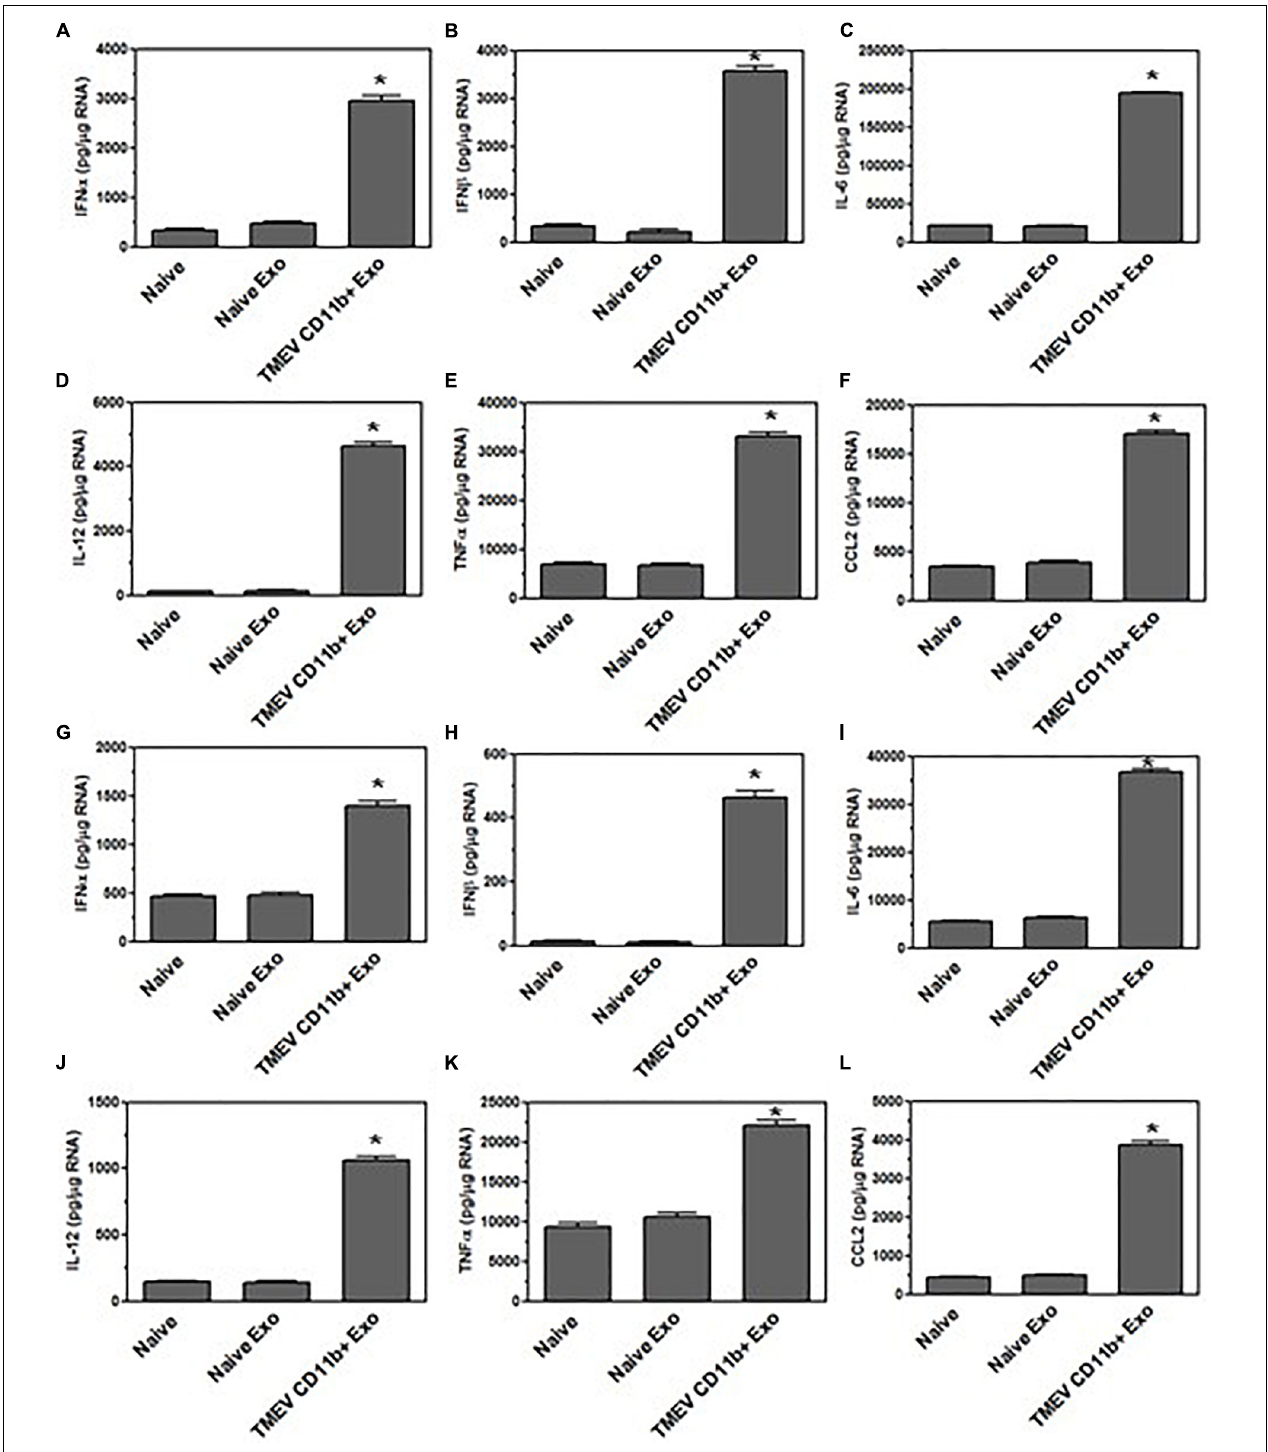
FIGURE 9 | Exosomes secreted by microglia during TMEV infection in mice activate bystander CNS cells. Exosomes were isolated from the brains of TMEV-infected mice at 2 days post-infection or from naïve mice (three mice per group). The exosomes were sorted for CD11b + exosomes which were placed on unstimulated astrocytes and neurons. After 24 h, the astrocytes (A–F) and neurons (G–L) were lysed, RNA isolated, converted to cDNA, and used in real time PCR with primers for IFN α (A,G) , IFN β (B,H) , IL-6 (C,I) , IL-12 (D,J) , TNF α (E,K) , and CCL2 (F,L) . Significant difference was determined by the one way ANOVA and Bonferroni’s multiple comparison test (* p < 0.001) based on naive astrocytes or neurons. These are representative graphs from one experiment of three independent repeated experiments.